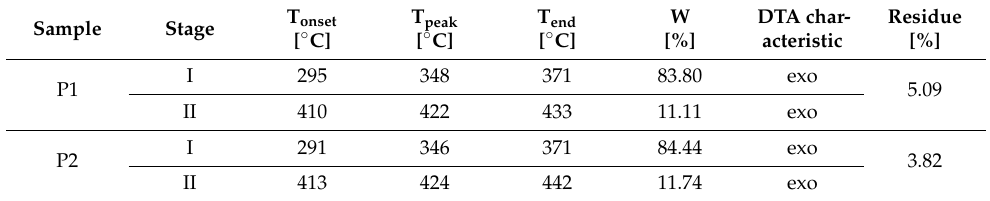
Table 3. Thermogravimetric